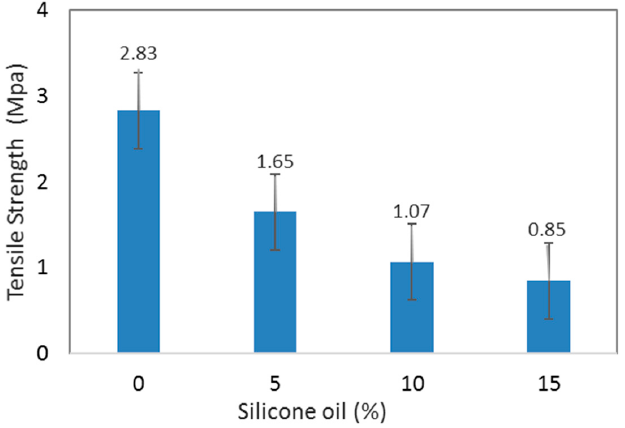
Figure 1. Tensile strength of isotropic MRE as a function of the silicone oil (SO) plasticizer content.